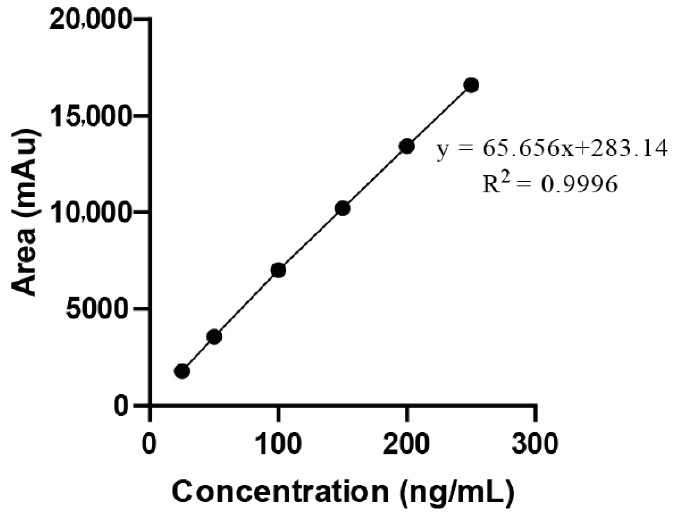
Figure 3. Representing the calibration curve of XH in plasma along with IS.